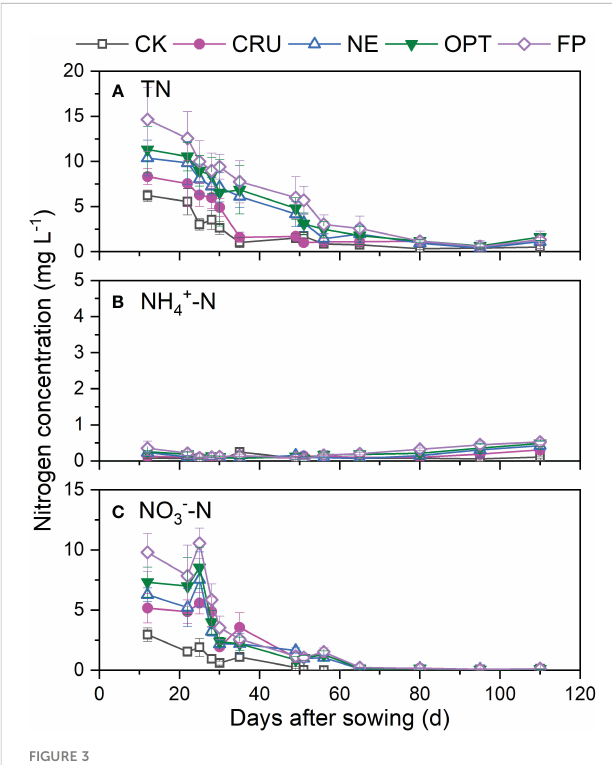
FIGURE 3 Dynamics of (A) TN, (B) NH 4+ -N, and (C) NO 3 – N concentration of the leaching water at 100 cm soil depth in the paddy fi elds under different treatments. The vertical bars mean standard deviations of the means CK, zero nitrogen application; CRU, controlled-release urea application; NE, nitrogen expert-based fertilization application strategy; OPT, optimized nitrogen fertilizer application strategy recommended by local government; FP, farmer's experience-based nitrogen fertilizer application